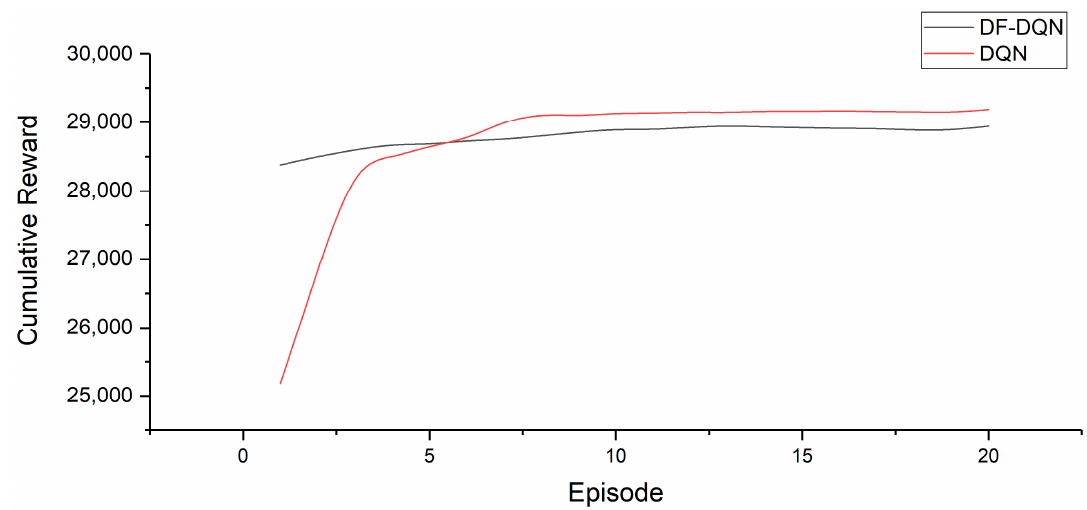
Figure 13. Comparison of cumulative reward between DQN and DF-DQN.